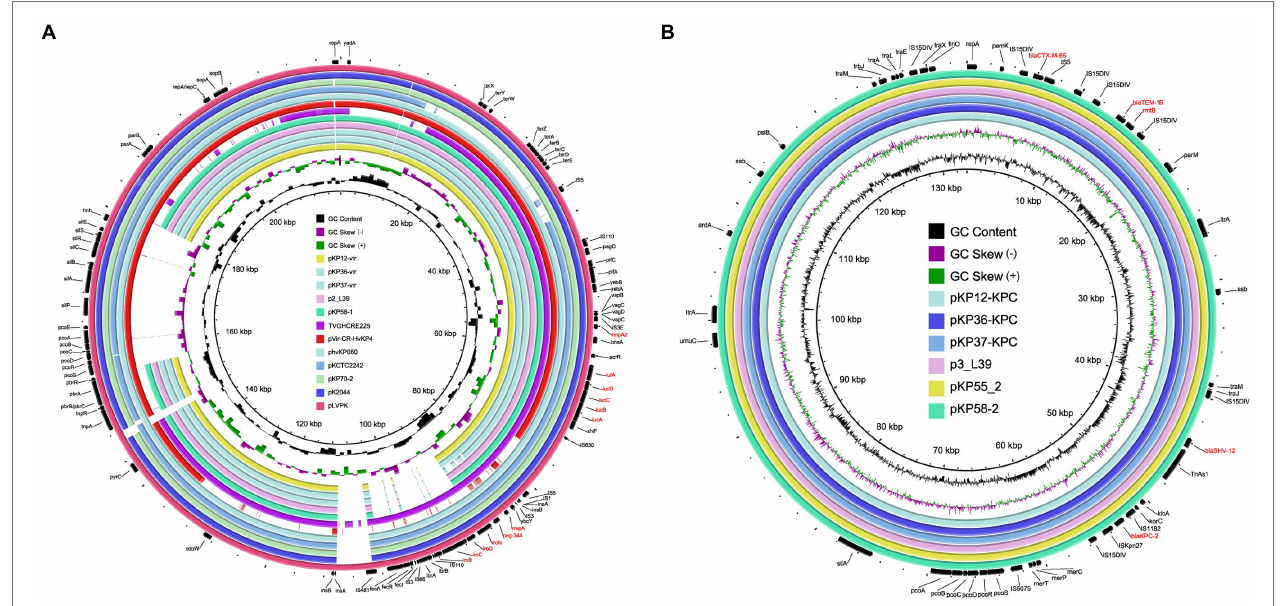
FIGURE 4 | Genetic comparison of virulence plasmids and bla KPC-2 -bearing plasmids recovered from K. pneumoniae KP12, KP36, and KP37 with similar plasmids in the NCBI database, respectively. (A) Alignment of virulence plasmids pKP12-vir, pKP36-vir, and pKP37-vir with p2_L39 (CP033955), pKP58-1 (CP041374), TVGHCRE225 (CP023723), pVir-CR-HvKP4 (MF437313), phvKP060 (CP034776), pKCTC2242 (CP002911), pKP70-2 (MF398271), pK2044 (AP006726), and pLVPK (AY378100). pLVPK was used as the reference plasmid. Virulence genes are highlighted in red. (B) Alignment of bla KPC-2 -bearing plasmid pKP12-KPC, pKP36-KPC, and pKP37-KPC with p3_L39 (CP033956), pKP55_2 (CP055296), and pKP58-2 (CP041375). p3_L39 was used as the reference plasmid. Antimicrobial resistance genes are highlighted in